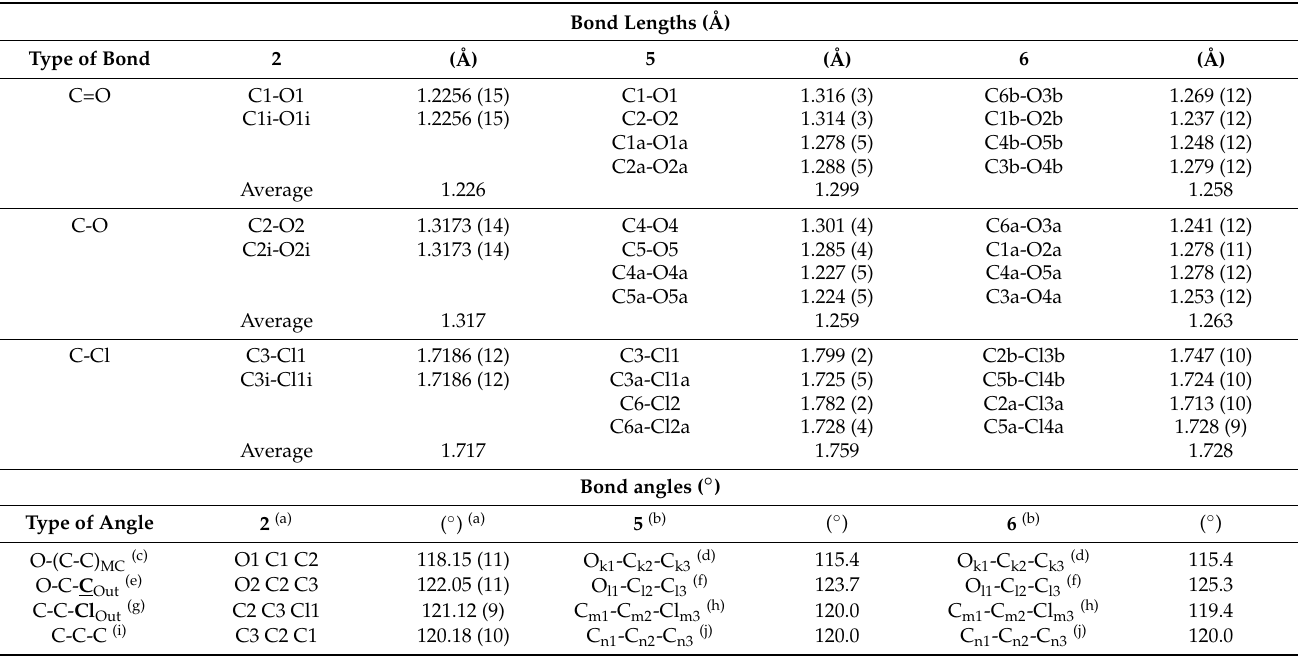
Table 2. Selected interatomic bond lengths and bond angles within the chloranilic acid/chloroanilate ligand in (caH 2 ) · 2H 2 O ( 2 ), (Et 4 N) cis -[NbO(ca) 2 (H 2 O)OPPh 3 ] · 3H 2 O · THF ( 5 ) and (Et 4 N) 4 [Nb 4 O 4 (ca) 2 ( µ 2 -O) 2 Cl 8 ] · 2CH 3 CN ( 6